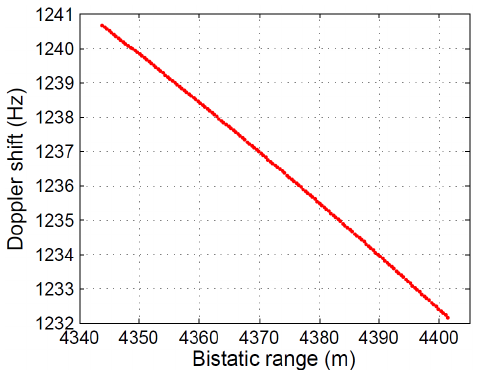
Figure 23. Virtual displacement for a fixed point inside the area of